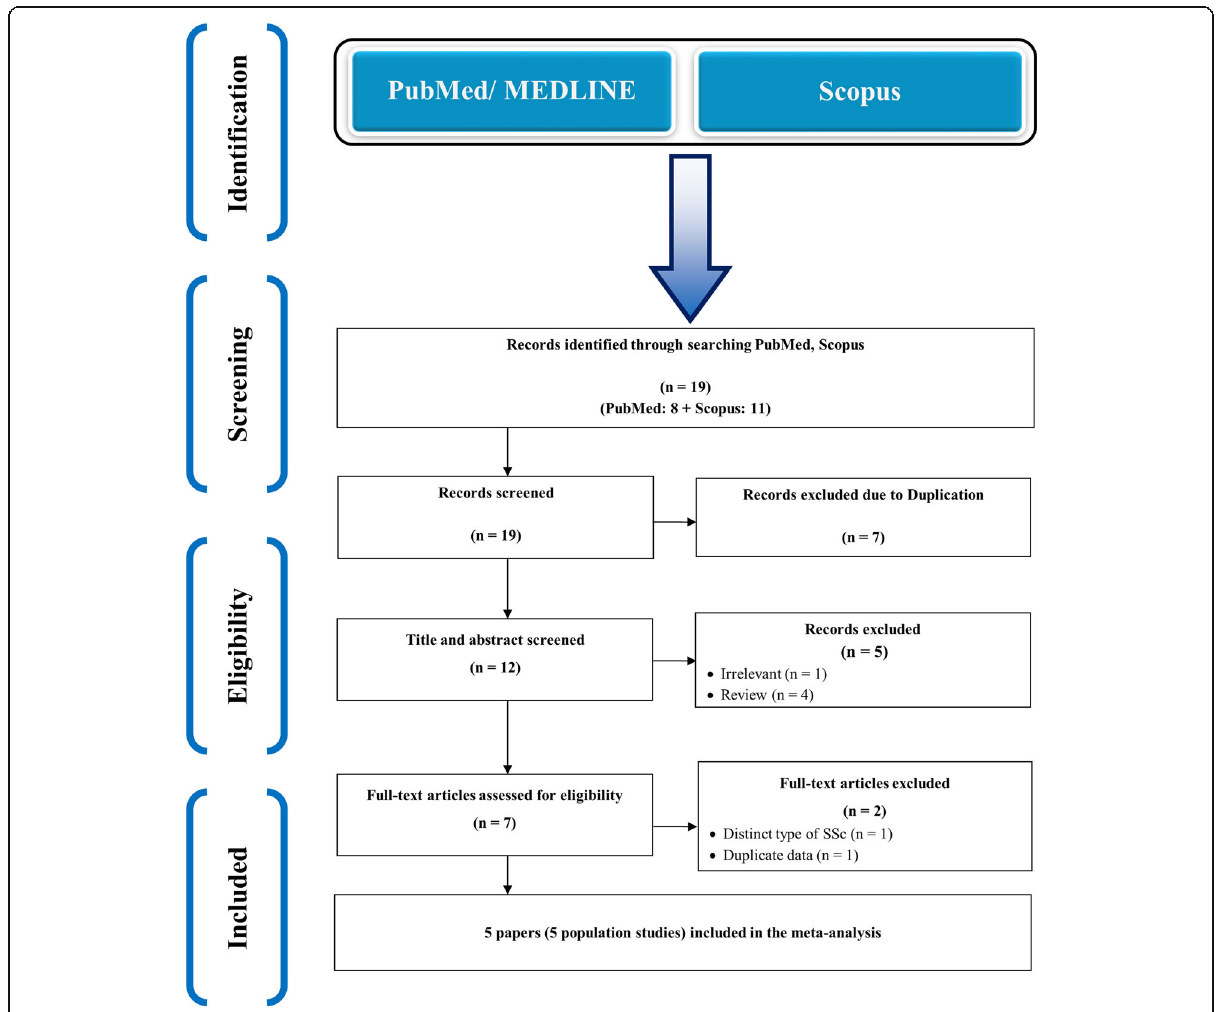
Fig. 1 Flow chart of specifications and procedure for the literature search and study selection